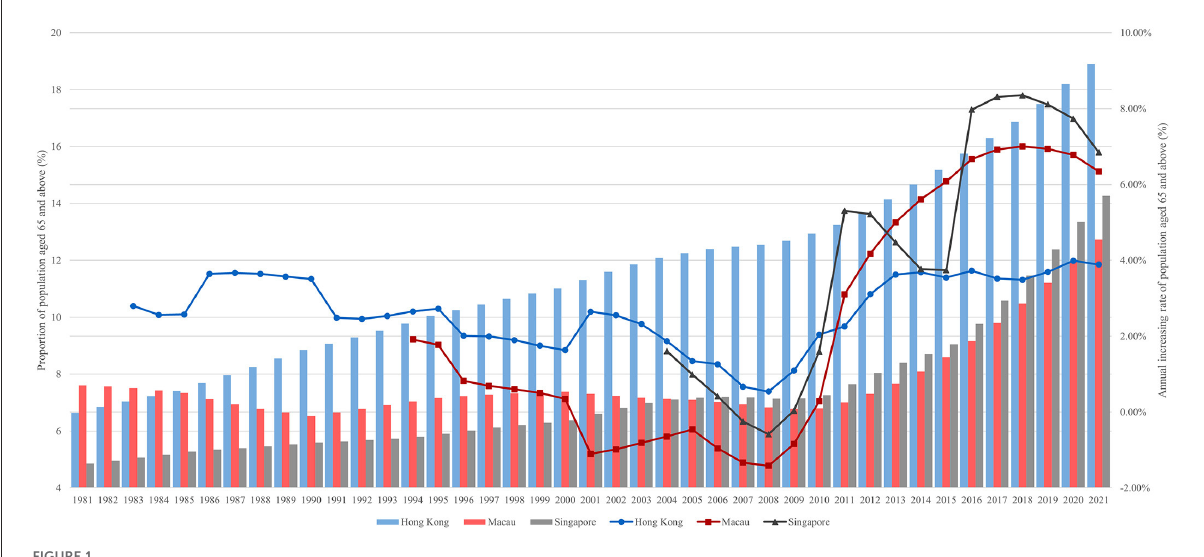
FIGURE1 Proportion of 65 + population and its annual increasing rate since entering an aging